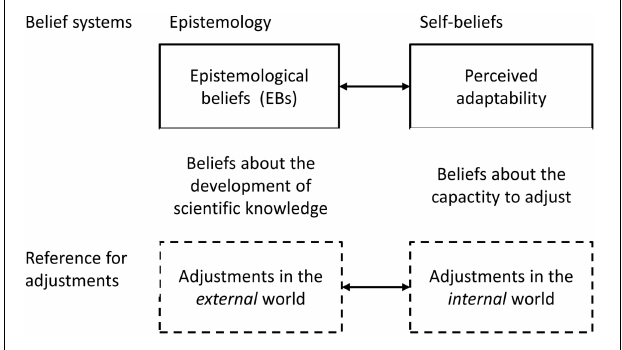
FIGURE 1 | Conceptual model underlying the relation between perceived adaptability and